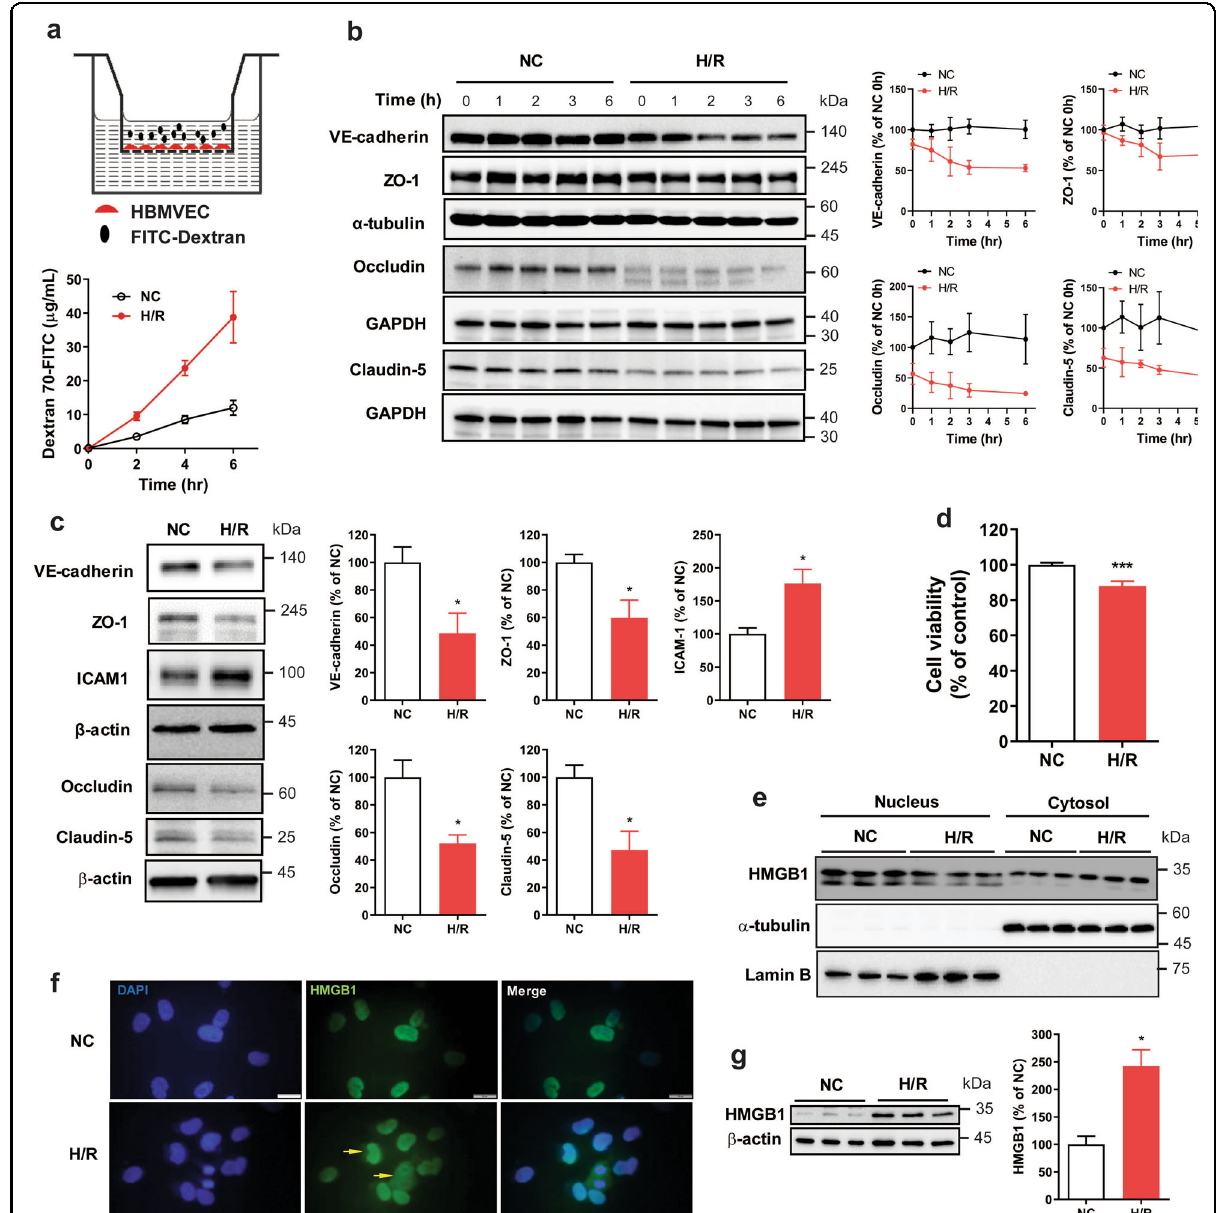
Fig. 1 H/R increased endothelial permeability and induced extracellular secretion of HMGB1 in HBMVECs. a, b HBMVECs were exposed to hypoxia/glucose deprivation for 1 h followed by reoxygenation (H/R) in complete medium for the indicated times. The in fi ltrated FITC-dextran level in the abluminal side ( a n = 6) and the expression levels of the junctional proteins VE-cadherin ( n = 6), ZO-1 ( n = 6), Occludin ( n = 3) and Claudin-5 ( n = 3) ( b ) during H/R for 6 h were measured; α -tubulin or GAPDH was used as a loading control. Representative blots are presented, and each graphs indicate the change in expression level relative to the level at 0 hr of normoxic control (NC) group, and vertical bars indicate mean ± SD. c Expression levels of VE-cadherin ( n = 5), ZO-1 ( n = 5), ICAM1 ( n = 5), Occludin ( n = 6) and Caludin-5 ( n = 6) in HBMVECs with 24-h H/R were analysed by western blot analysis. β -Actin was used as a loading control. Representative blots are presented. Each bar graphs indicate the relative expression level of each protein to that of NC (mean± SD; * p < 0.05 versus NC by unpaired t -test). d Cell viability of HBMVECs exposed to 24-h H/R was measured by MTT assay. Bar graphs indicate the mean ± SD. *** p < 0.001 versus NC. e Levels of HMGB1 prot e in in the nucleus and cytosol were analysed by western blotting. Lamin B and α -tubulin were used as loading controls for nuclear and cytosolic proteins, respectively. f HBMVECs with or without H/R treatment were fi xed in paraformaldehyde and stained with an anti-HMGB1 antibody. Arrows indicate the cytosolic HMGB1 in cells treated with H/R for 2 h; not observed in NC. Horizontal white bars indicates 50 μ m. g Levels of extracellular HMGB1 protein in CM from HBMVECs with or without 24-h H/R exposure were measured by western blotting; β -actin was used as a loading control ( n = 4-5, mean ± SD; * p < 0.05 versus NC by unpaired t- test). Representative blots are